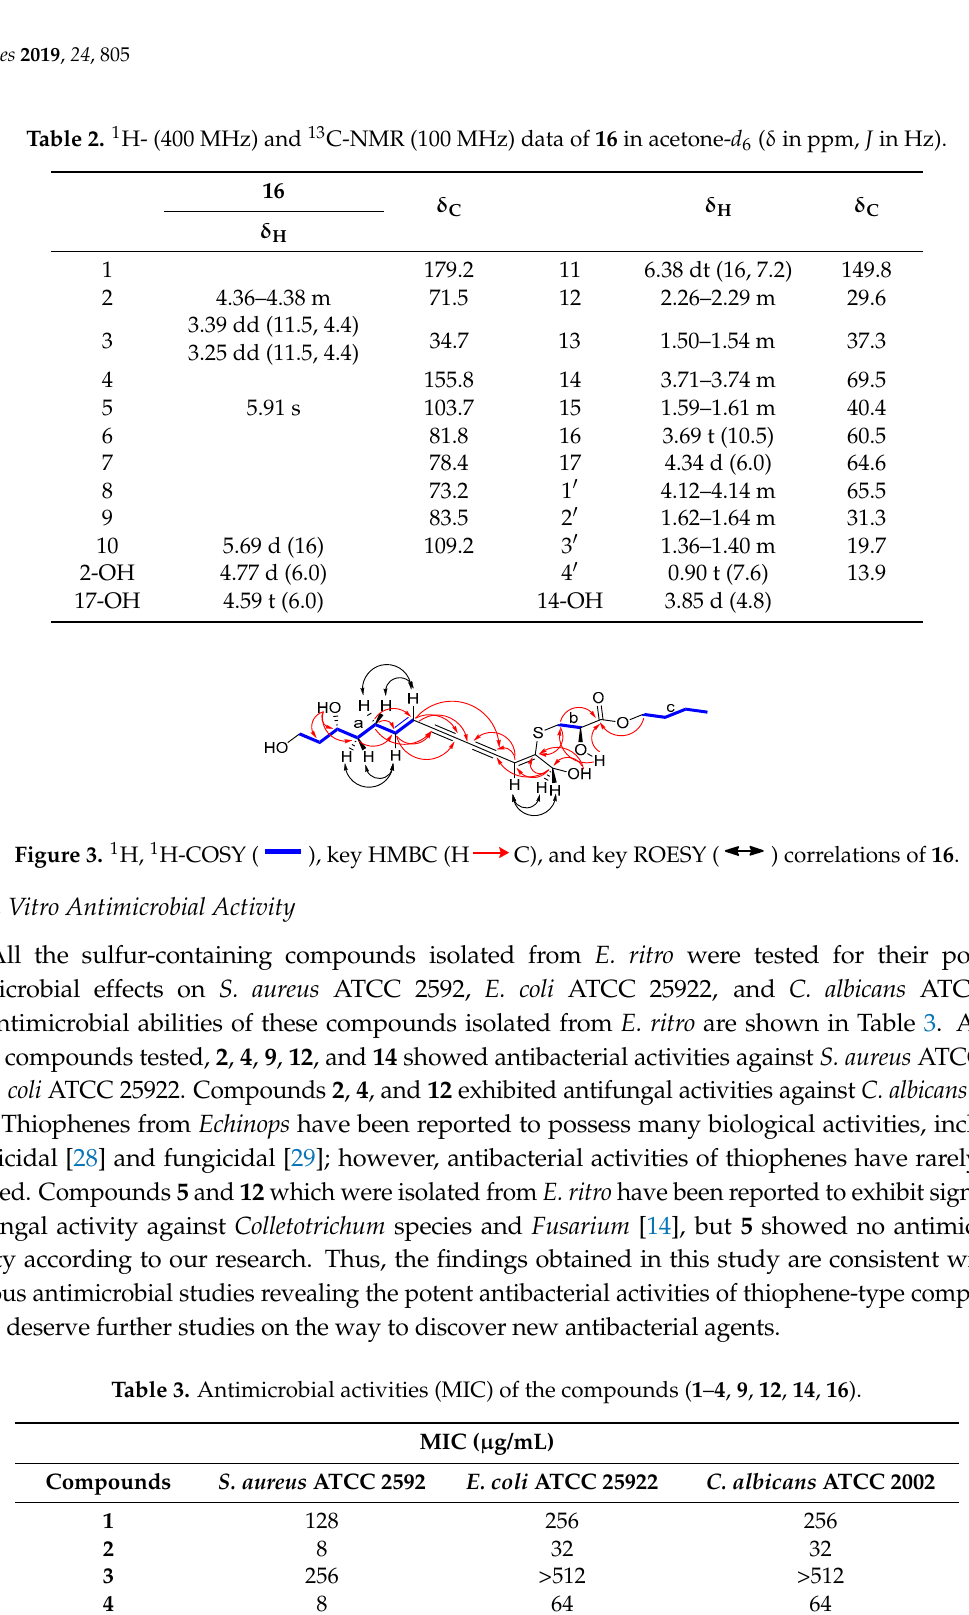
Molecules 2019 , 24 , 805